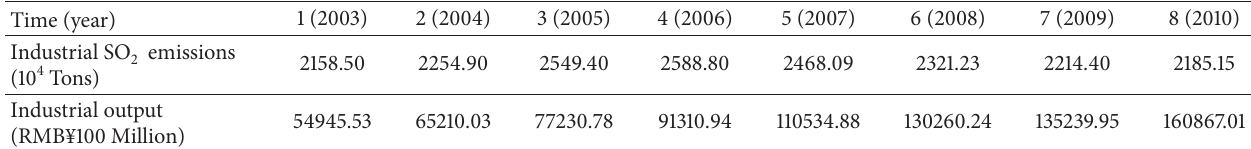
emissions and gross industrial output values of 2003–2010. 2